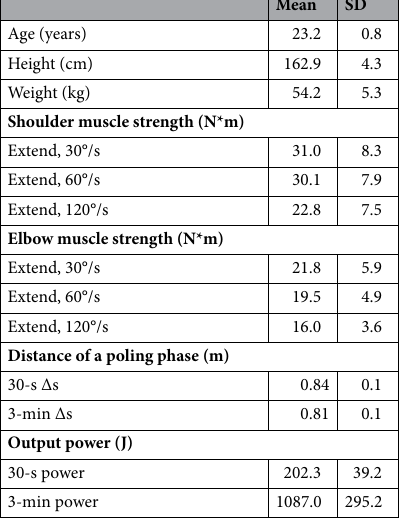
Table 1. The measured isokinetic muscle extension strength at low speed was larger than at high speed, both in shoulder and elbow joints. In the tests of 30-s and 3-min, the poling distance of the poling phase was similar (0.84 m and 0.81 m, respectively), and the variance of the two data was small (SD = 0.1 m). Correlations among technical performance, output power, and upper limb isokinetic muscle strength. 30-s was significantly correlated with isokinetic muscle extension strength of shoulder at all three different angu- lar velocities of 30°/s (r = 0.39, p = 0.102), 60°/s ( r = 0.61, p = 0.005) and 120°/s ( r = 0.58, p = 0.01). Sit-skiing DP output power of 3-min was also significantly correlated with ioskinetic muscle extension strength of shoulder at all three different angular velocities of 30°/s ( r = 0.47, p = 0.045), 60°/s ( r = 0.66, p = 0.002) and 120°/s ( r = 0.63, p = 0.004). There was no significant relation between isokinetic muscle strength of elbow and sit-skiing output power. ∆s of 30-s and 3-min were not significantly correlated with shoulder or elbow muscle extension strength. As shown in Fig. 1A,B and E,F, ∆ s was significantly and positively correlated with output power both in 30-s (right hand, r = 0.73, p < 0.001; left hand, r = 0.77, p < 0.001) and 3-min (right hand r = 0.63, p = 0.001; left hand r = 0.68, p < 0.001) test. Overall, ∆ t was not significantly correlated with the output power (Fig. 1C,D and G,H). Relationships between output power and upper limb isokinetic muscle strength. Multiple stepwise regression analysis between upper limb isokinetic muscle extension strength and the sit-skiing DP output power showed that muscle extension strength of shoulder at 60°/s accounted for 34% of the variance in